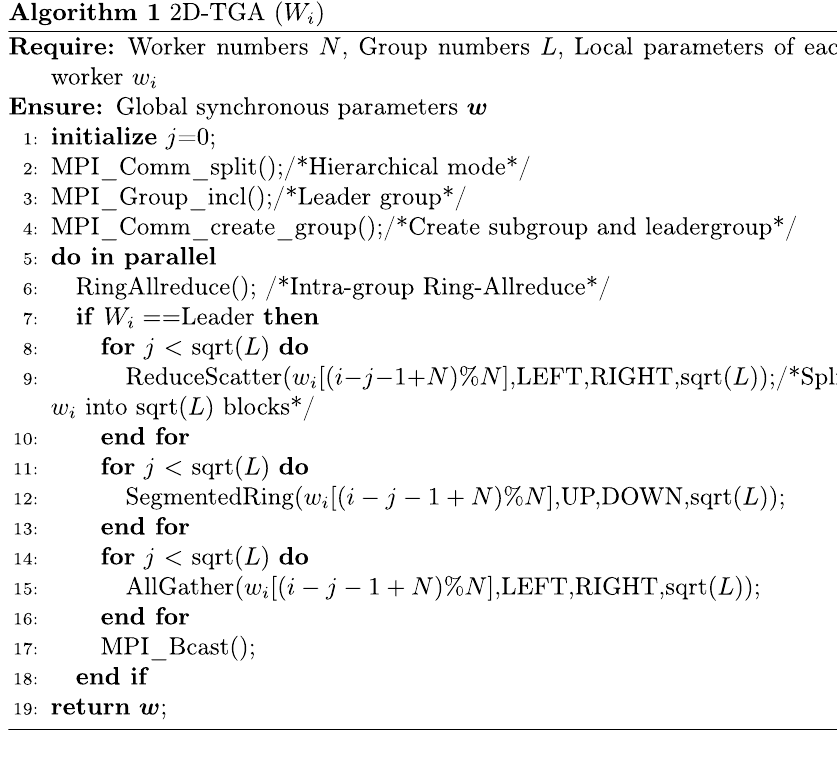
Perform Segmented-Ring operation vertically. d Perform AllGather operation horizontally. e The first group performs the broadcast oper-